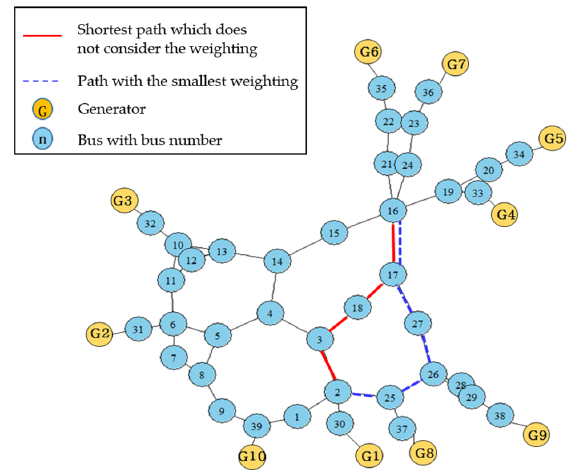
Figure 3. The example of applying the enhanced Dijkstra algorithm.